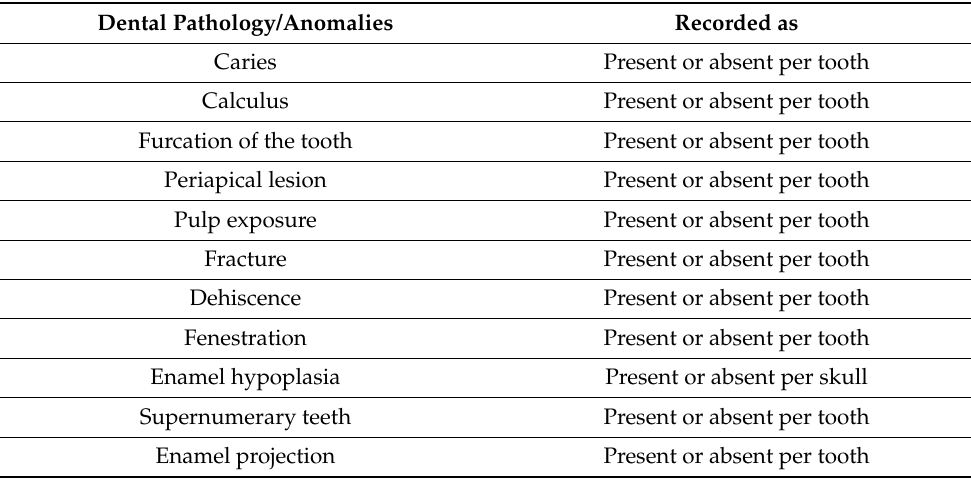
Table 2. Dental pathology/anomalies